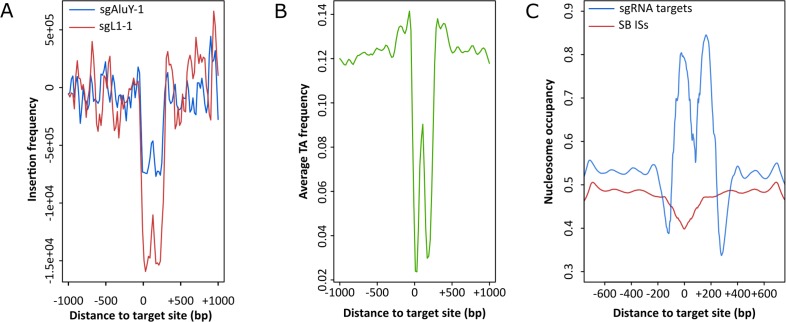
Analysis of targeted chromosomal regions.(A) Insertion frequencies of the targeted (blue) and non-targeted (red) dataset show that statistically significant (p=0.019) enrichment occurs within a 300 bp window downstream of sites targeted by sgAluY-1, which is generally disfavored for SB integration. (B) Reduced average TA di-nucleotide frequency the targeted 300 bp window. (C) Computationally predicted nucleosome occupancy around the sites targeted by sgAluY-1 (blue) and around untargeted SB insertion sites (ISs, red).